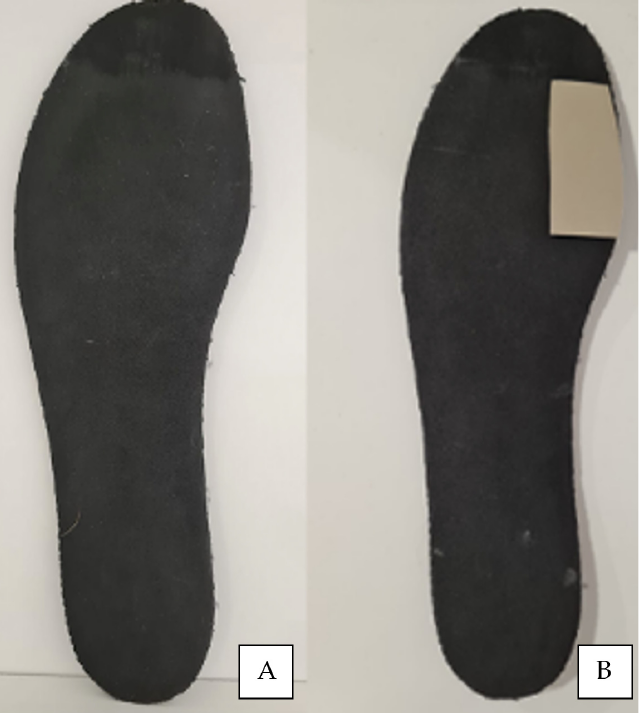
Figure 1. Flat insole ( A ) and flat insole with Morton’s extension beneath first-ray load from a plantar vision ( B